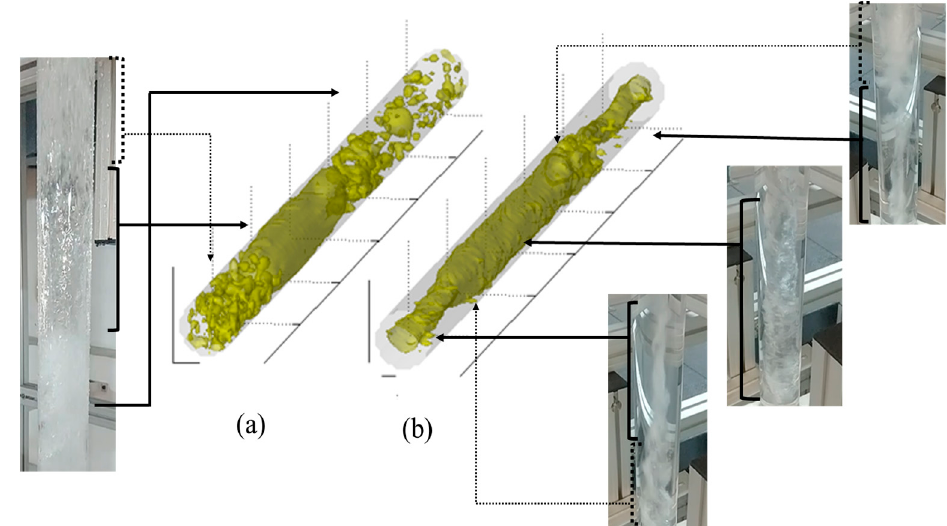
Figure 6. Slug flow images with wire-mesh and camera: ( a ) Input and ( b ) inside the cyclonic chamber.